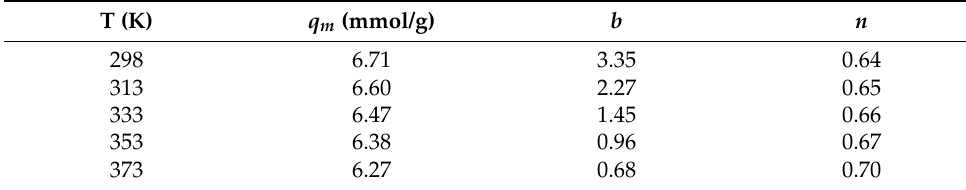
Table 7. Constant values of the Sips isotherms of CO 2 adsorption on Li 0.61 Na 0.39 X. Table 6. Constant values of the Sips isotherms of CO 2 adsorption on NaX. T